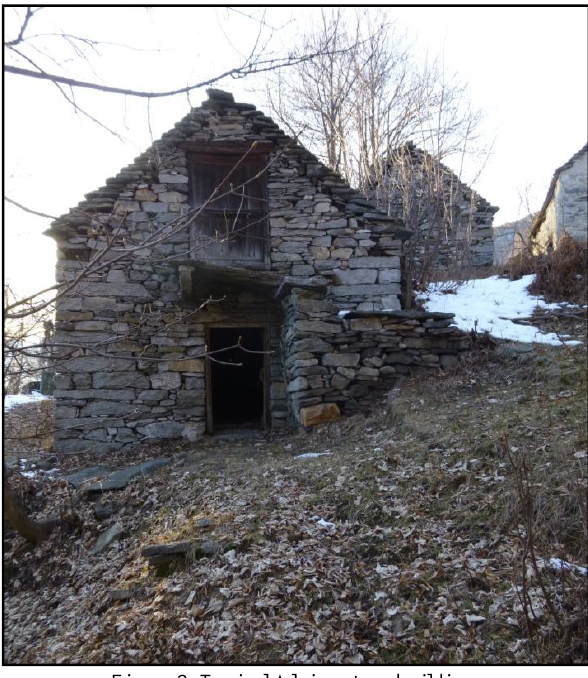
Figure 2. Typical Alpine stone